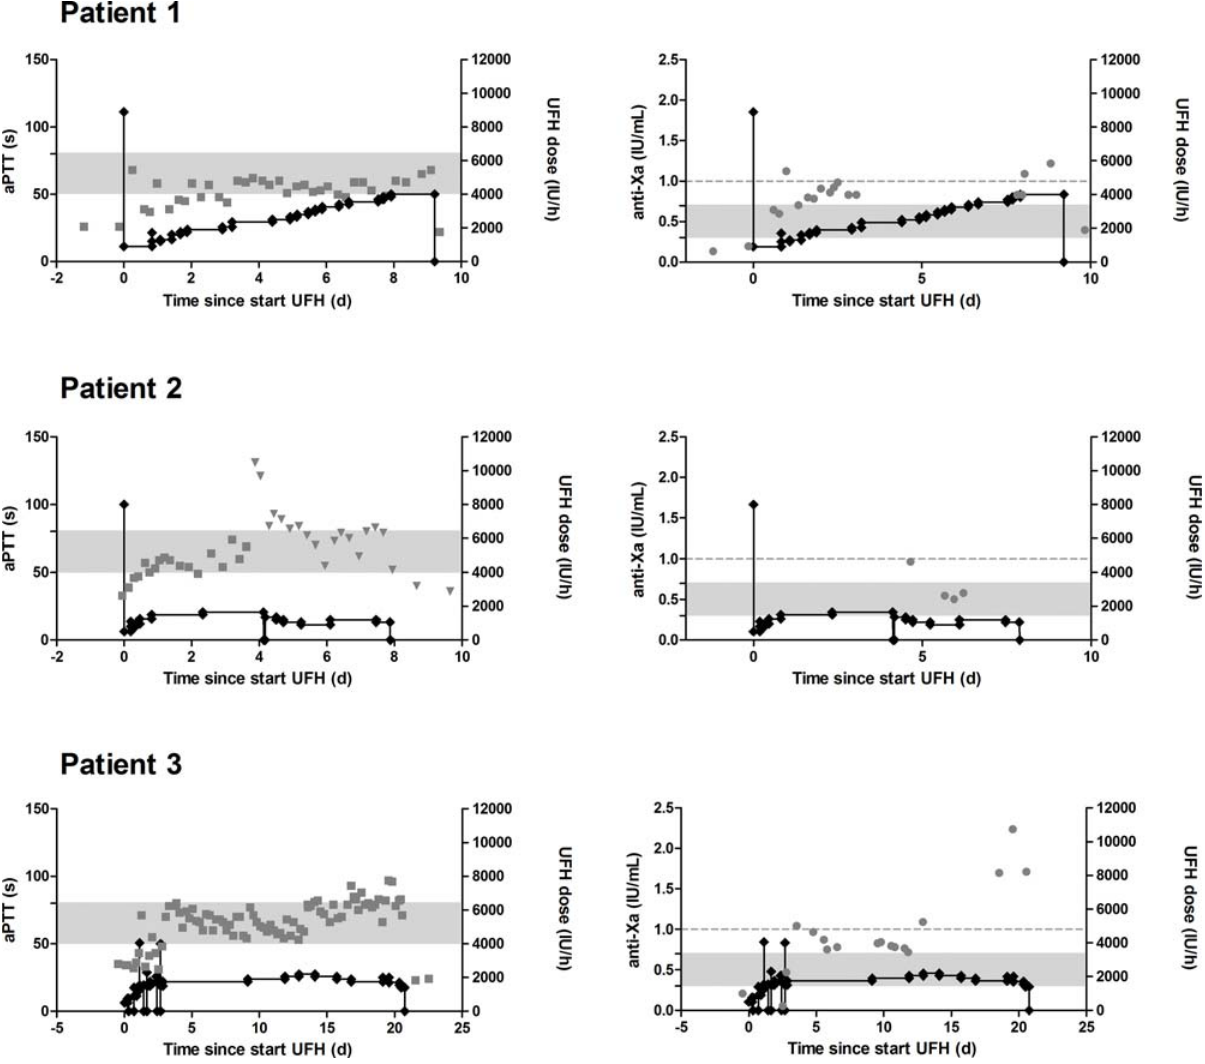
Fig. 1 Longitudinal data of 7 patients treated with unfractionated heparin (UFH) and on extracorporeal membrane oxygenation (ECMO) or continuous venovenous hemo fi ltration. The left-hand panels show the activated partial thromboplastin time (aPTT) (measured with the Sysmex CS2100i (optical method), ; or with the Stago STA-R Max 2 (mechanical method), plotted on the left y-axis. The right-hand panels show the anti-Xa activity ( ) plotted on the left y-axis. All fi gures also show the actual administered UFH dose in IU/h ( ), plotted on the right y-axis. Bolus injections are in IU and are shown as vertical spikes. Shaded area indicates the heparin therapeutic range (50 – 80 seconds for the aPTT, 0.3 – 0.7 IU/mL for the anti-Xa). Dashed lines indicate the 1.0 IU/mL anti-Xa cutoff. Red symbols in patient 7 indicate aPTTvalues > 150 seconds and anti- Xa values > 2.5